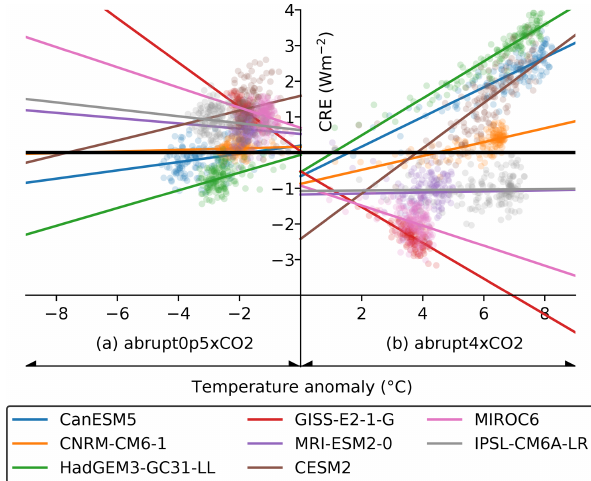
Figure 10. Cloud radiative effect (CRE) regressed on global surface temperature anomaly in abrupt0p5 × CO 2 (a) and abrupt4 × CO 2 (b) experiments by CMIP6 models.